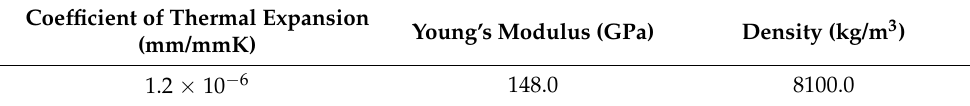
Table 2. Mechanical properties of ASTM F1684 [21].